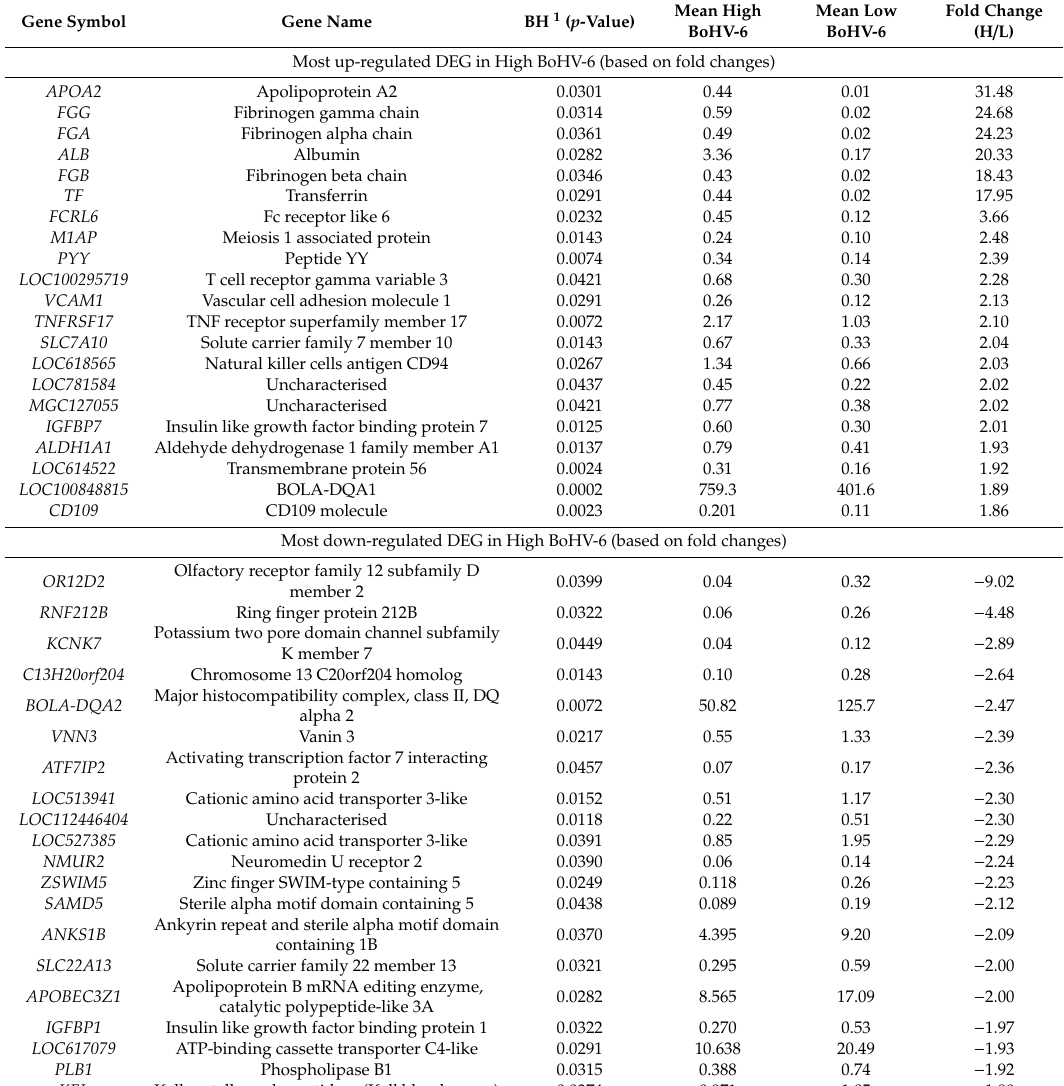
Table 6. Gene expression levels in circulating leukocytes collected at around 14 days in milk compared between cows with High (H, > 200) and Low (L, 1-200) BoHV-6 scores, listing the Top 20 most up-regulated and down-regulated genes in High BoHV-6